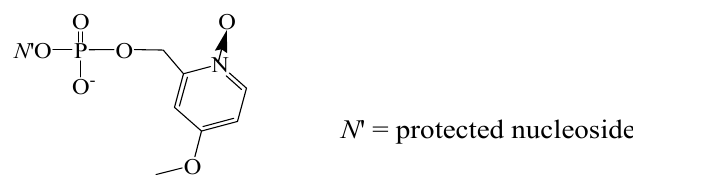
Figure 9. Four-component H -phopsphonate phosphorothioate ODN